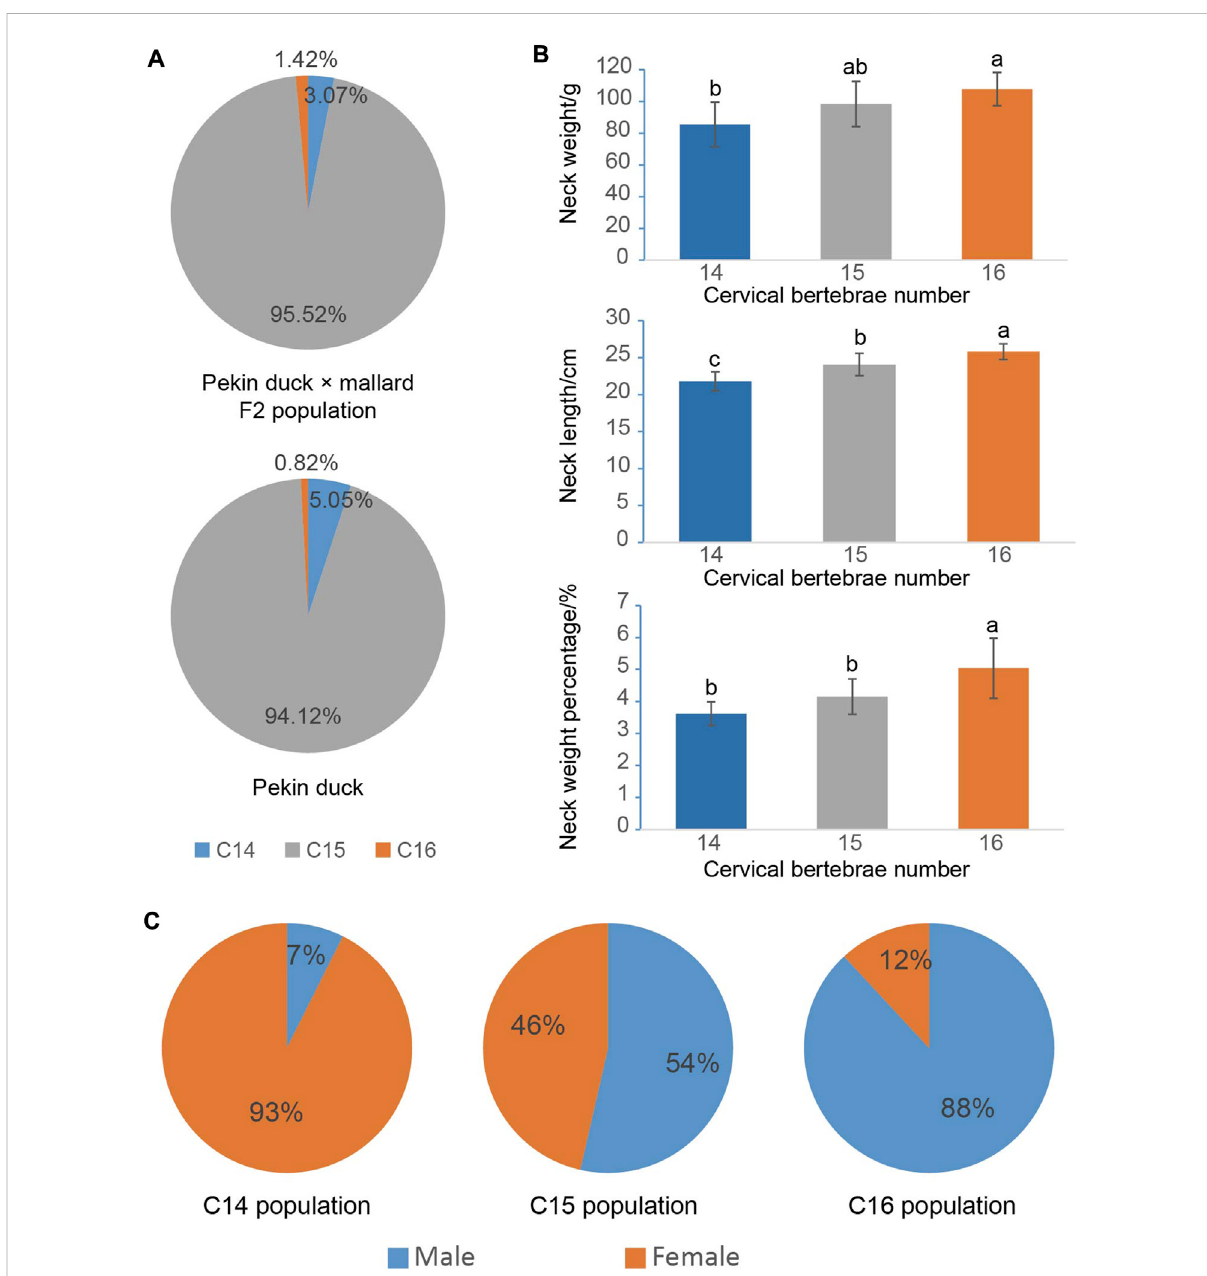
FIGURE 2 Phenotypic distribution ofthecervicalvertebra number andtheir effectson economic traits. (A) Phenotypic distributionofthecervicalvertebra numberinthePekinduck×mallardF2populationandthePekinduckpopulation. (B) Theeffectsofthecervicalvertebranumberonneckweightand neck length; alphabet differences between the groups represent statistically signi fi cant difference with the Duncan test; bars represent the standard deviation of the mean. (C) Distributionsof C14 (14 cervical vertebrae), C15(15 cervical vertebrae), and C16 (16 cervical vertebrae) phenotypes in the male and female Pekin duck